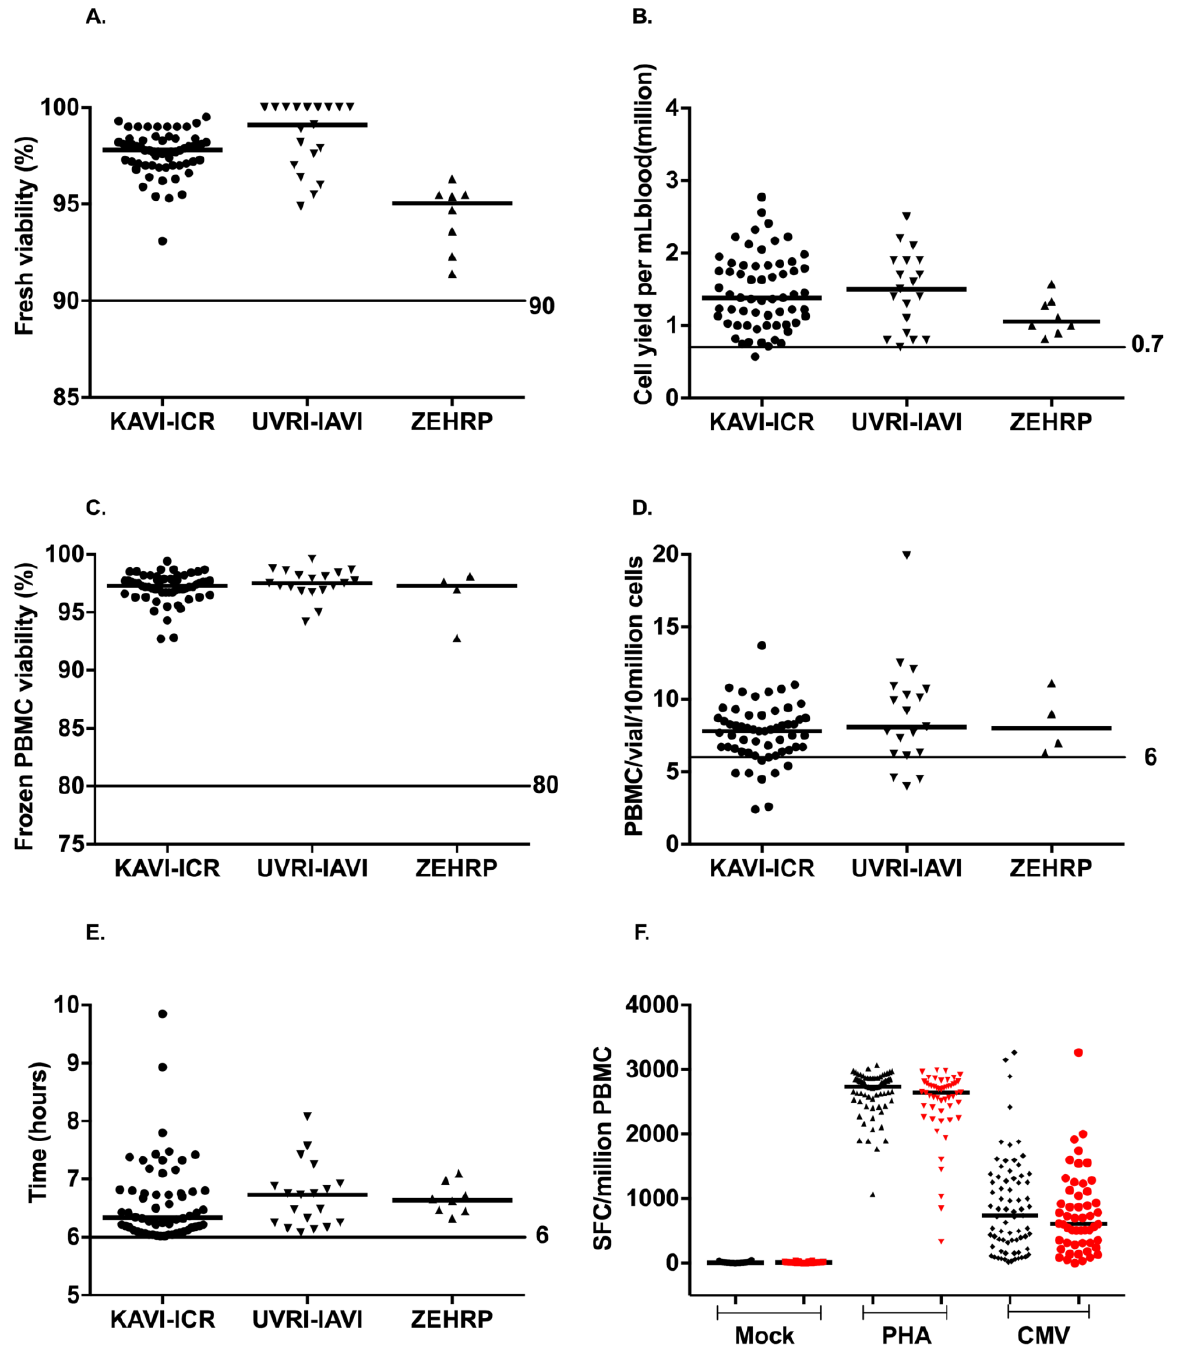
FIGURE 1-S1: Cell recovery, viability and ELISpot responses of samples processed beyond 6 hours : A) viability from freshly isolated PBMC; B) cell yield per mL blood; C) viability from frozen samples; D) cell recovery of PBMC per 10 million cells frozen following thaw and overnight rest; E) processing time from blood draw to freezing of PBMC ; F) ELISpot responses of PBMC tested against mock, PHA and CMV stimuli for PBMCs processed within 6 hours (red) and beyond 6 hours (black). Each point in the scatter plot represents a sample and the median (horizontal line). Horizontal lines represent the acceptance